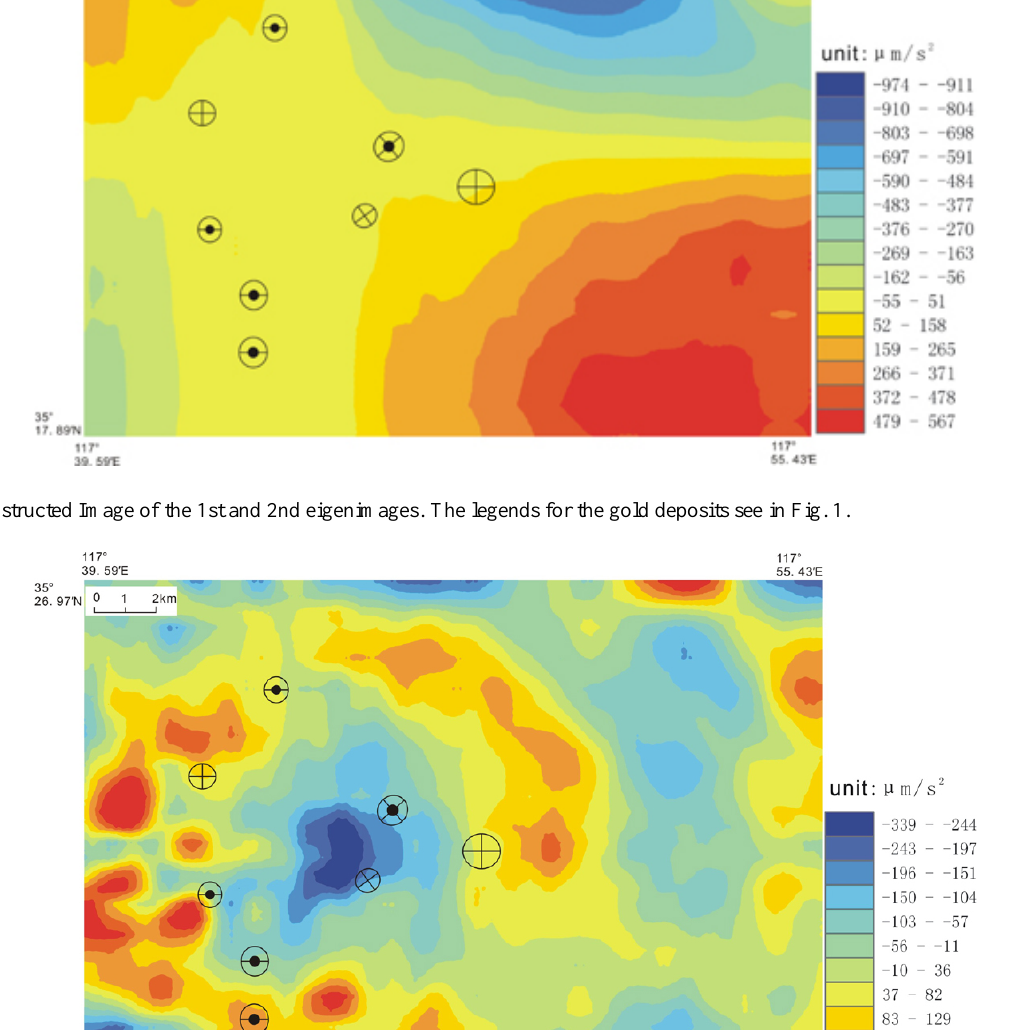
gravity image with the sum from 3rd to 8th eigenimages (Fig. 5) usually reflects local ore-controlling factors. The left segment is made of ranking from λ 9 to λ 35 ,and the percentage of its energy is only about 1% of total